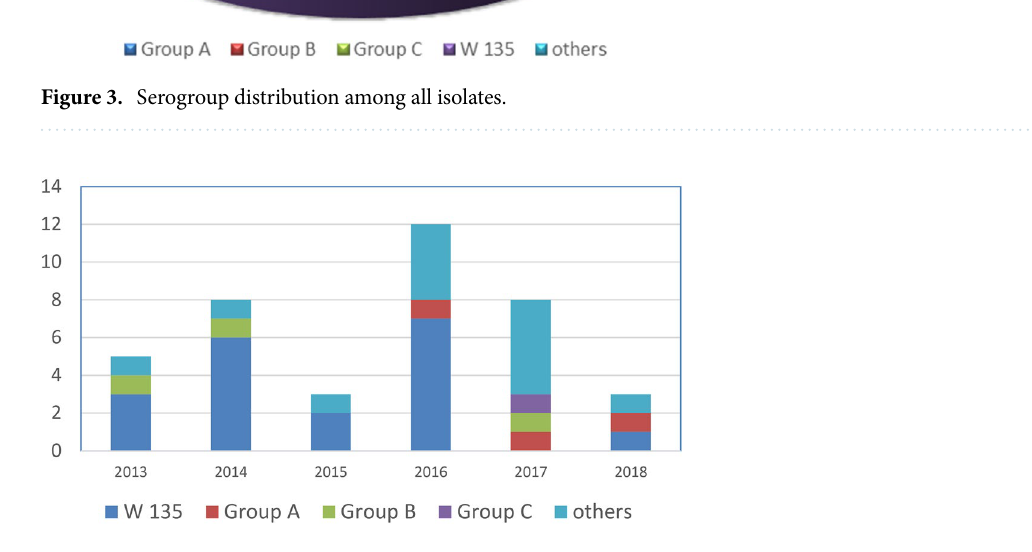
Figure 4. Occurrence of Neisseria meningitidis